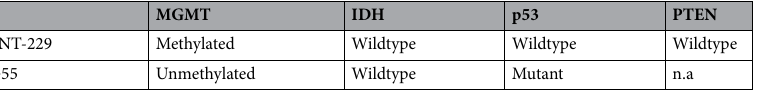
Table 1. Genetic background of LNT-229 and G55 cells. MGMT, IDH, p53 and PTEN status of G55 and LNT- 229 cells 33